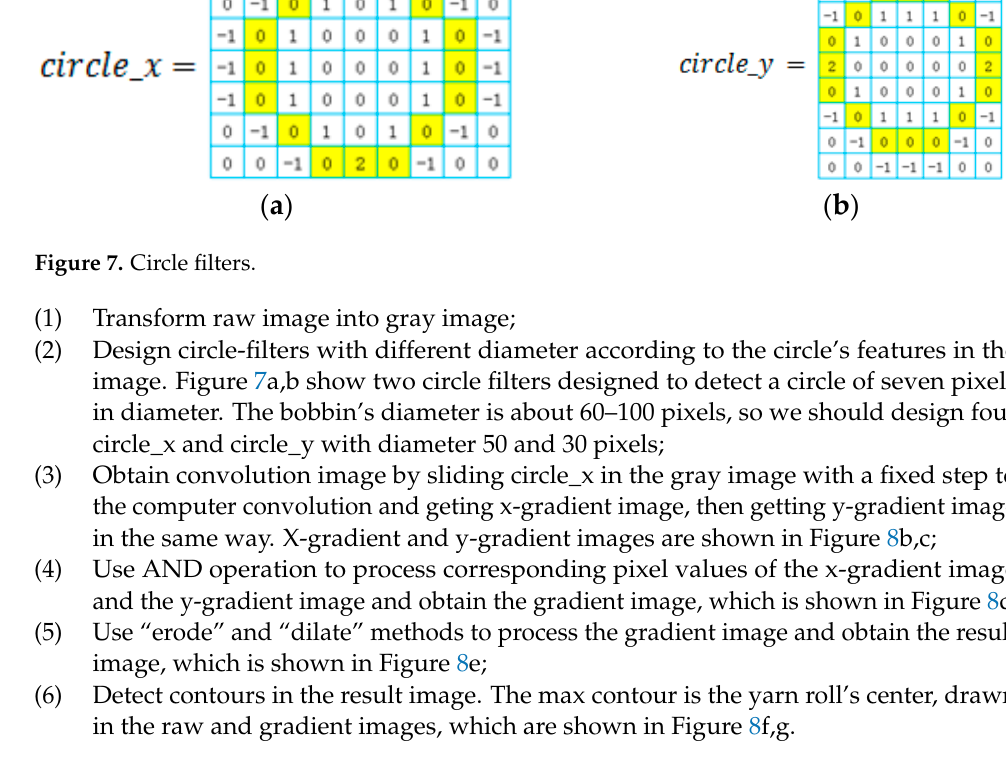
Figure 8. Center detection process.